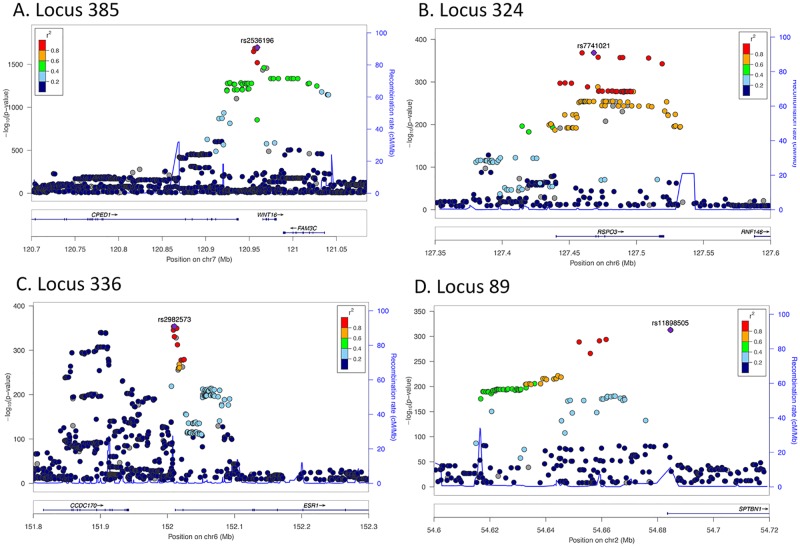
Regional-association plots for eBMD.A. Locus 385. B. Locus 324. C. Locus 336. D. Locus 89. Tested SNPs are arranged by genomic position (x-axis) around the lead SNP (purple diamond). The y-axis on the left indicates -log10 p-values for association with eBMD for each SNP. The y-axis on the right indicates recombination rate shown with a blue line. The color of dots of the flanking SNPs indicates their linkage disequilibrium (R2) with the lead SNP as indicated by the heat map color key.